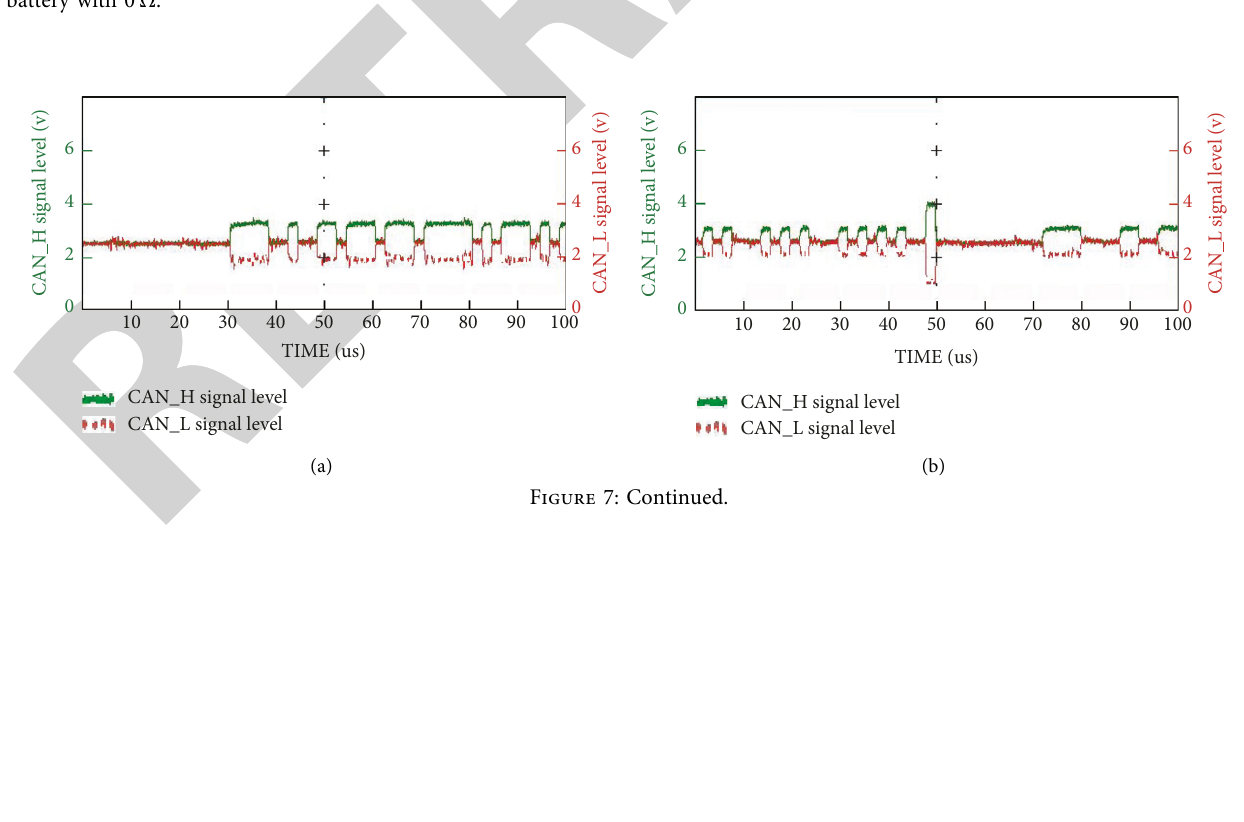
Figure 6: Signal waveform of PT-CAN_L to battery loaded with different resistances. (a) PT-CAN_L load resistance to battery with 2.5k Ω . (b) PT-CAN_L load resistance to battery with 150 Ω . (c) PT-CAN_L load resistance to battery with 30 Ω . (d) PT-CAN_L load resistance to battery with 0 Ω